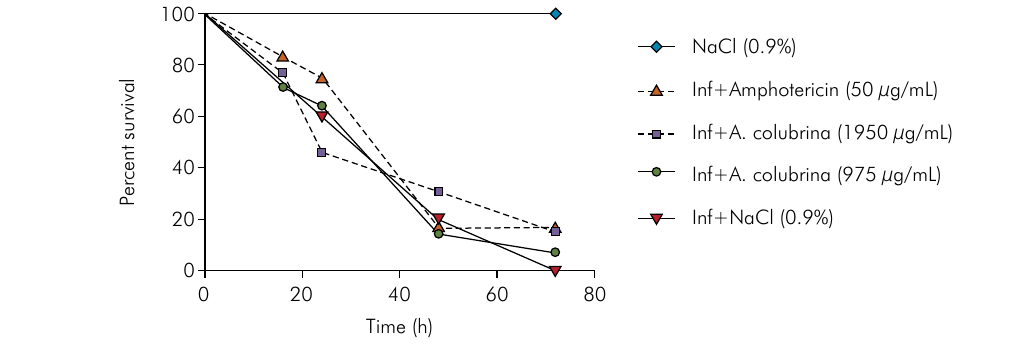
Figure 4. Treatment of systemic infection by C. albicans with amphotericin 100xMIC (50 µg/mL), A. colubrina 50xMIC (975 µg/ mL), A. colubrina 100xMIC (1,950 µg/mL) e vehicle of dilution (NaCl 0.9%) in G. mellonella model (p > 0.05, log-rank